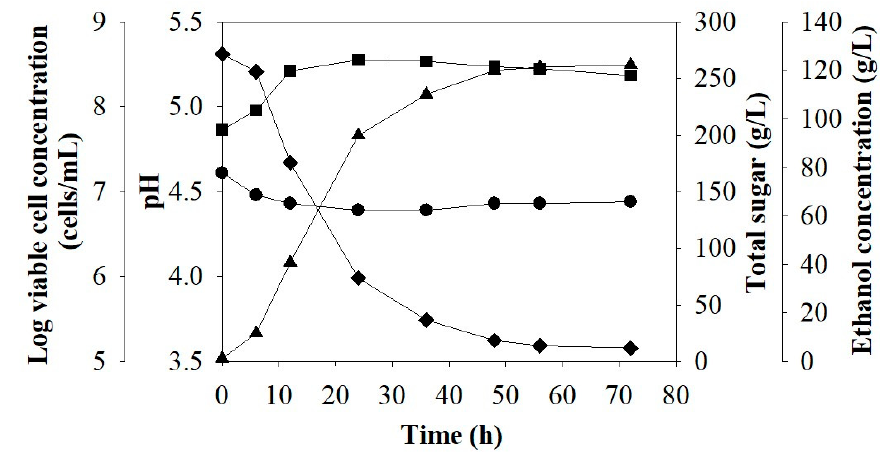
= total sugar and  = ethanol).